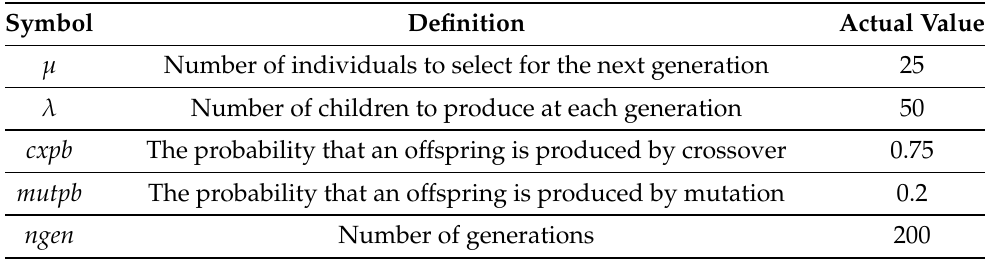
Table 6. Summary of GA parameters and the values used in our